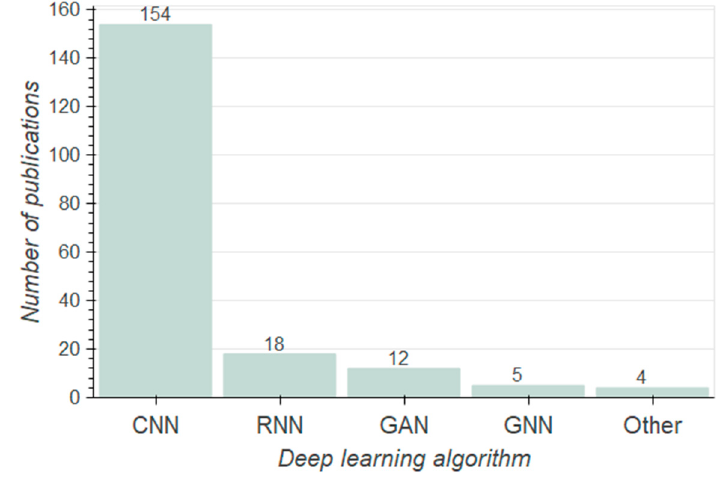
Figure 9. The improved DL algorithms with attention mechanism in the papers.